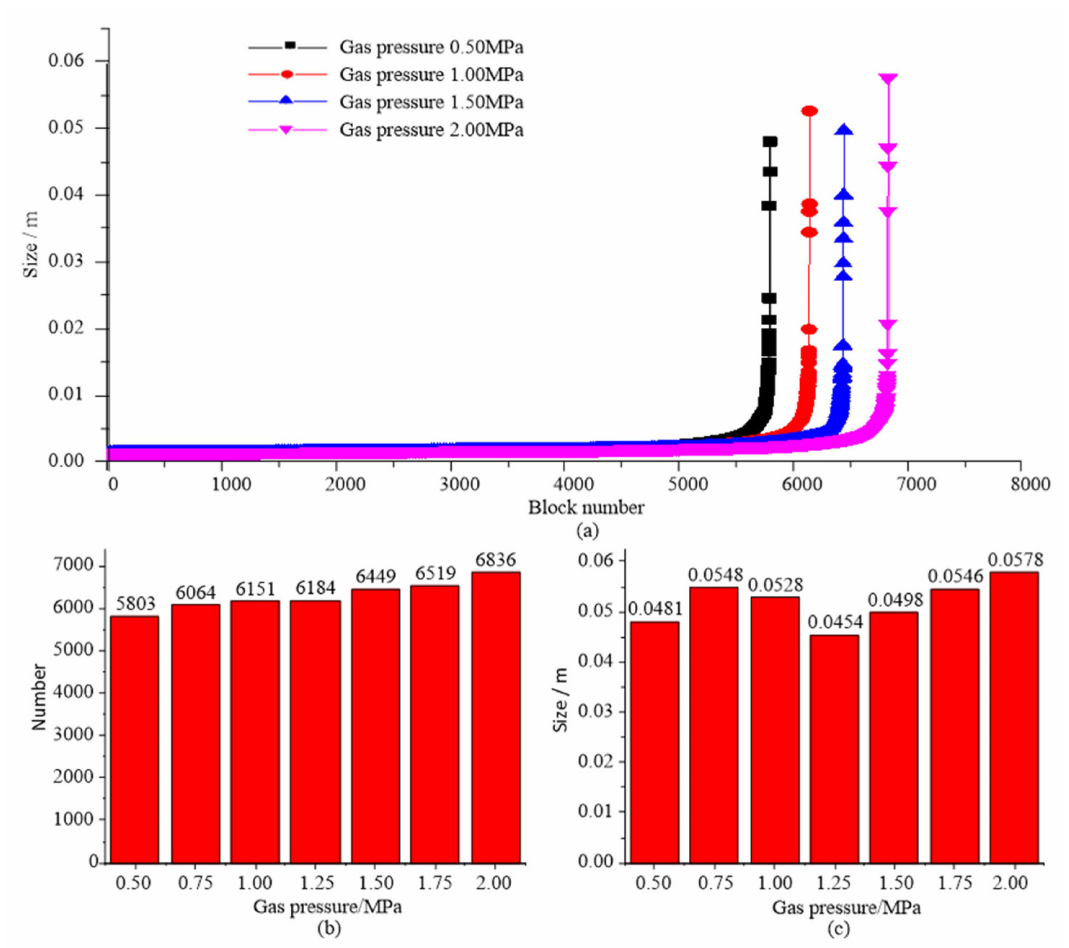
Figure 11. The maximum number and size statistics of the fracture block of coal samples with different pore gas pressures: ( a ) characteristic size curves of fracture rock block; ( b ) fracture block number comparison; and ( c ) maximum block size